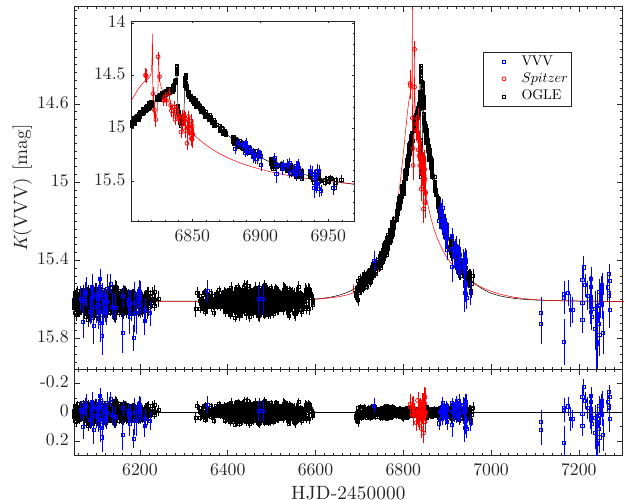
Figure 2. Light curve of the planetary model of OGLE-2014-BLG-0124 as observed from Earth by OGLE in I band (white) Vista 4 m at Paranal in H band (blue) and by Spitzer at 3.6 µ m (red), which was located ∼ 1AU East of Earth in projection at the time of the observations. The Jovian planet appeared ∼ 20 days earlier in Spitzer data compared to the ground. The mass ratio star/planet is well constrained from the modeling. The initial estimate of the mass of the host star is ∼ 0.7 M (cid:12) d and the planet ∼ 0.5 M jup (based on OGLE, Spitzer, [49]). The ground space-born parallax is giving an accurate mass-distance relation for the lens. We combined it with the mass-distance coming from high angular resolution observations to derive the physical parameters of the system